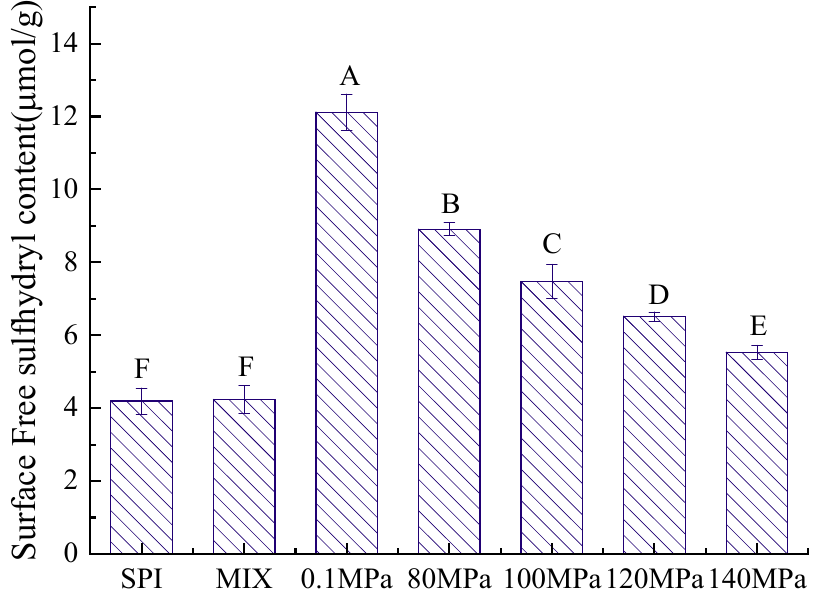
Figure 5. Surface free sulfhydryl content of the samples. SPI is the native soy protein isolate; MIX represents the mixture of SPI and GOS; 0.1 MPa represents the traditional wet heating Maillard reaction group; 80 MPa, 100 MPa, 120 MPa, and 140 MPa are the HPH treatment groups. The letters A–F indicate decreasing orders of magnitude ( p < 0.05).